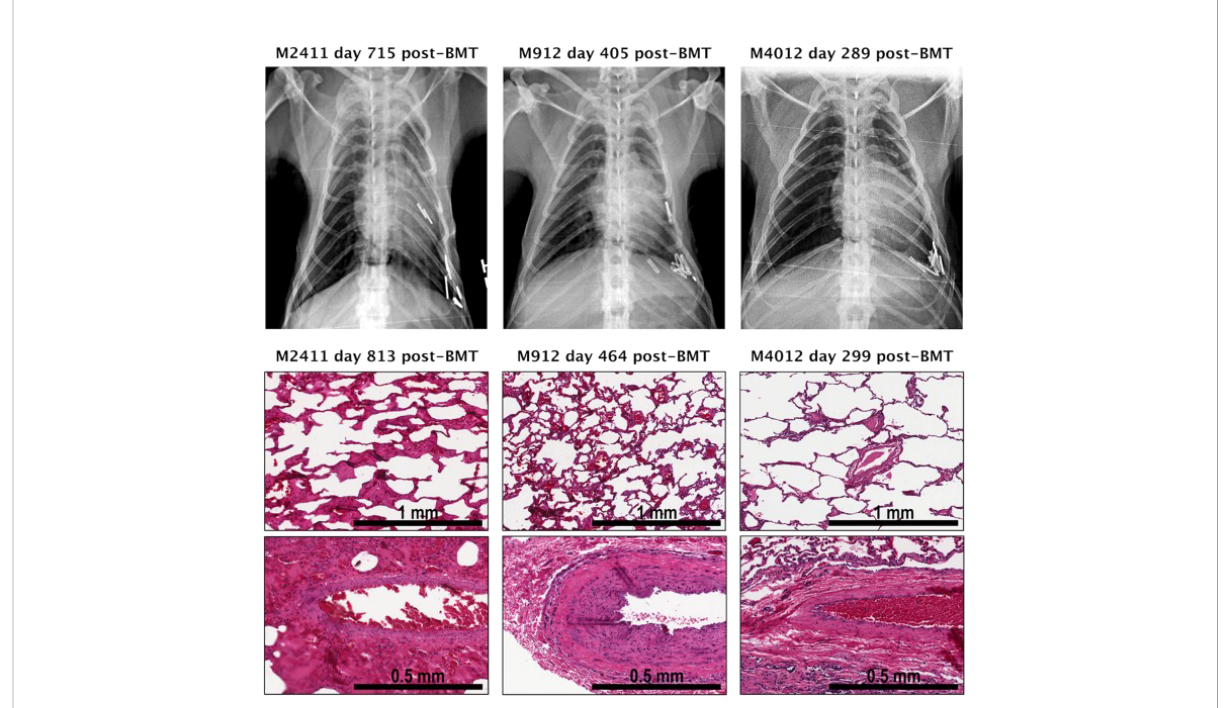
FIGURE 2 Pathology and chest radiographs from three tolerant NHP lung transplant recipients that underwent delayed donor bone marrow transplantation. Shown are photomicrographs (hematoxylin and eosin (H&E) staining) of lung biopsies performed at the time of euthanasia and chest radiographs obtained at indicated time points from each recipient. The chest radiographs of NHP recipients M2411, M912, M4012 displayed well-aerated lung allografts in the left thoracic space. No signs of rejection were seen in the lung graft biopsy of M2411, M912, and M4012. Adapted from (181). BMT, Bone marrow